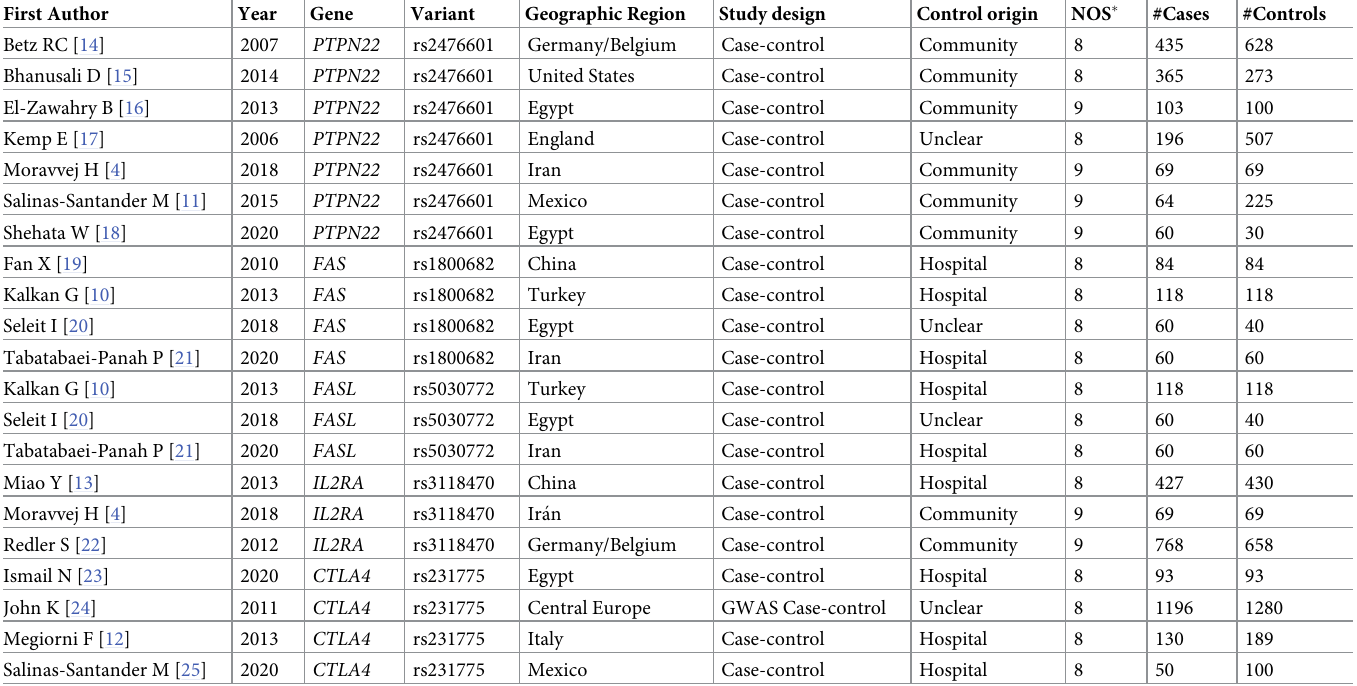
Table 1. Characteristics of the studies included in the systematic review and